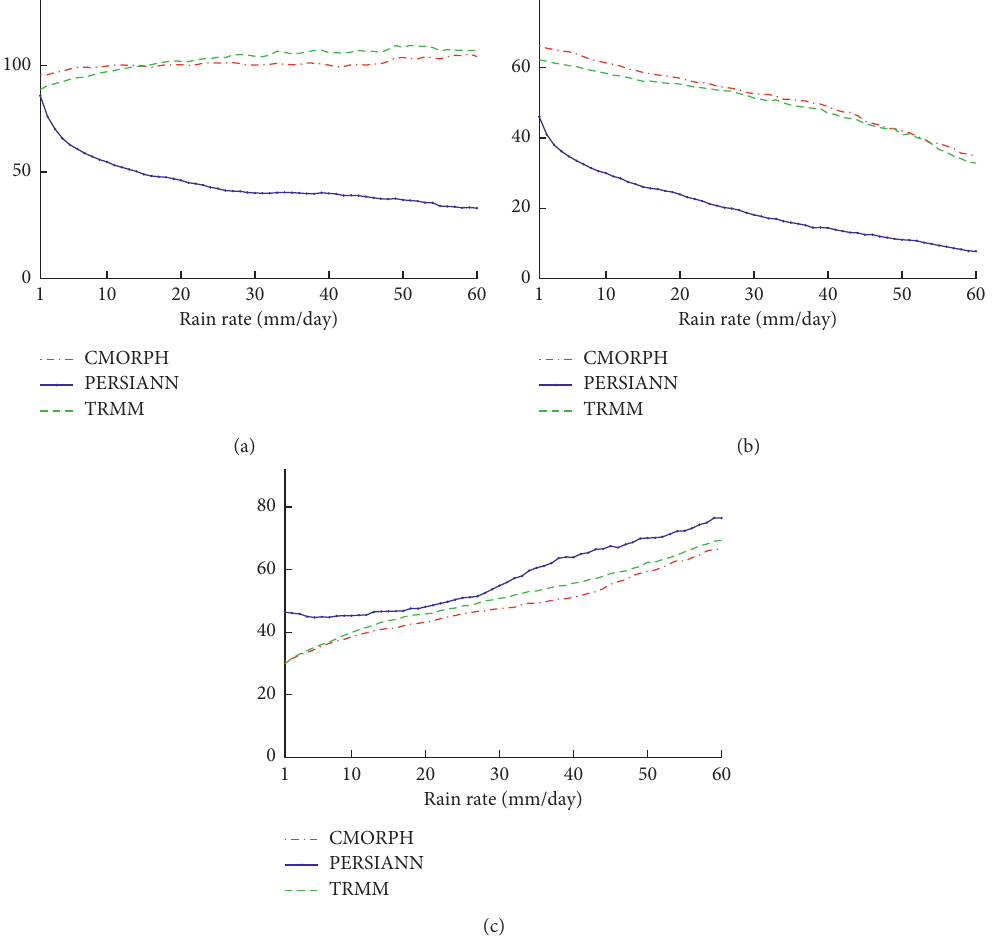
Figure 12: (a) The hit bias, (b) the probability of detection, and (c) the false alarm rate of each satellite product on a daily